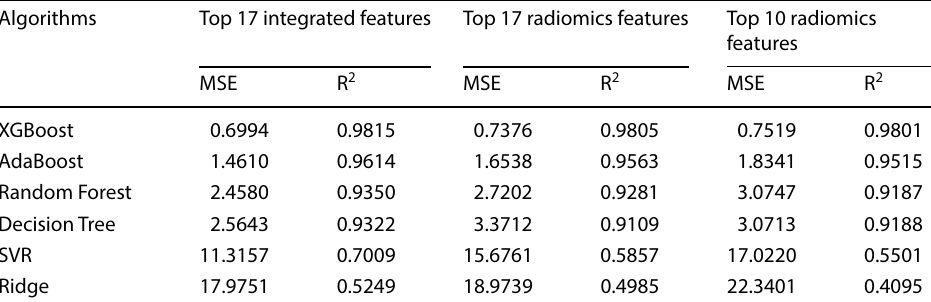
Top 17 integrated features, including top 10 radiomics, 4 clinical and 3 DVH